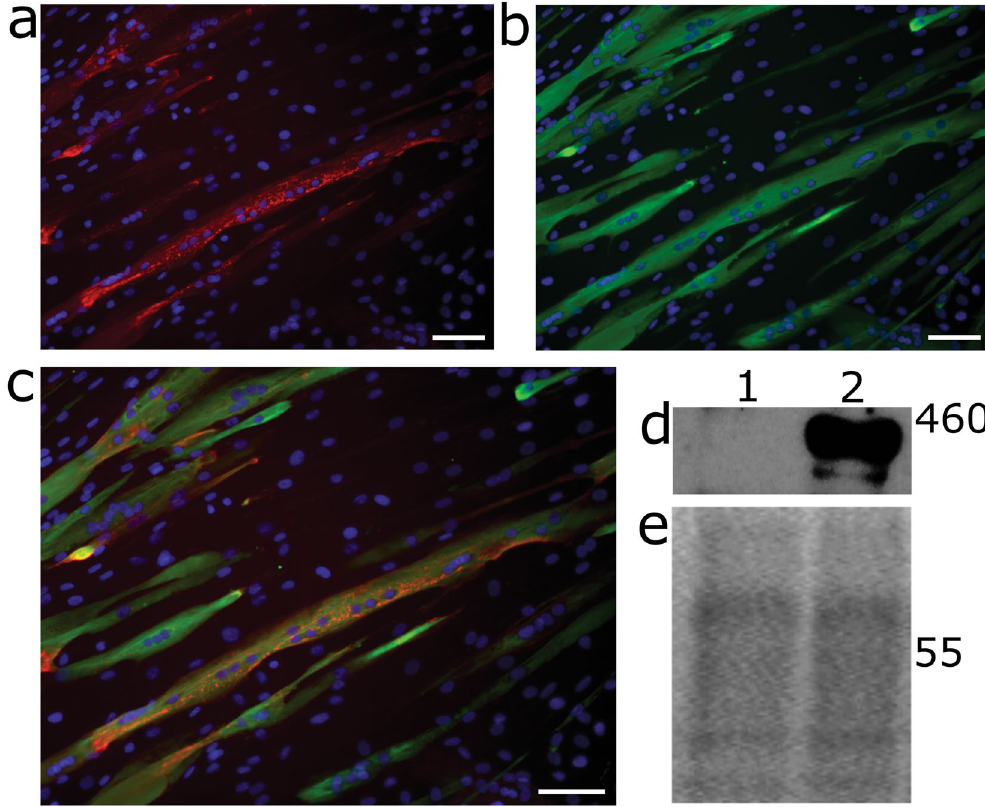
Figure 6. Transduced muscle derived cells form myotubes in vitro and express full-length dystrophin. ( a – c ) Representative immunofluorescence photomicrographs of muscle derived cells (cell line 3) transduced at an MOI of 1 with DDF-SFFV-coDys-oPRE showing expression of dystrophin ( a ) and myosin heavy chain ( b ) with DAPI stained nuclei (blue) following differentiation. A merge of a and b is shown ( c ). Scale bar is 25 µ m. ( d ) Western blot on lysates from muscle derived cells (cell line 2). Lane 1 - untransduced; lane 2 - transduced with DDF-SFFV-coDys-oPRE at an MOI of 1. Full-length blot is shown in Fig. S6f. Ponceau S staining served as a loading control ( e